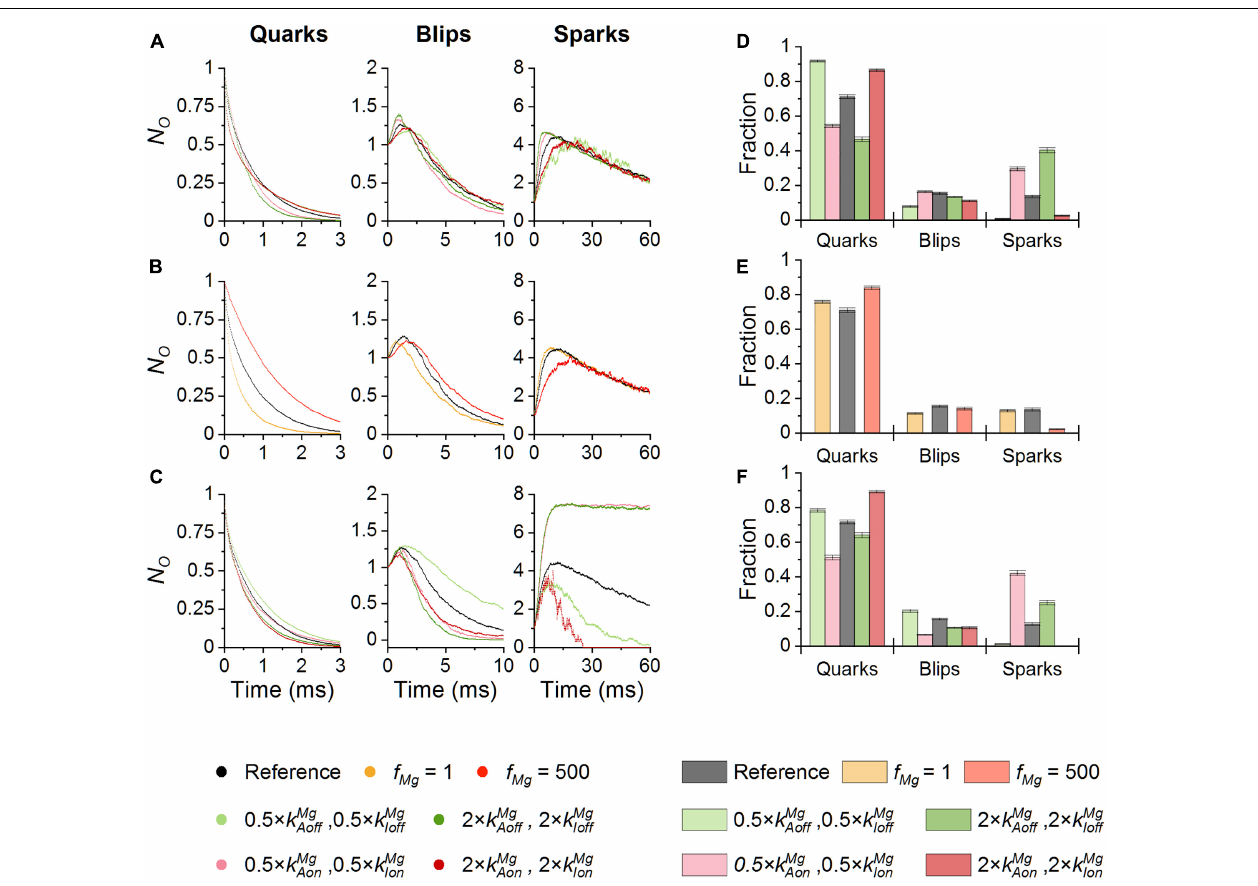
FIGURE 6 | The effect of Mg-binding parameters on CREs. Simulations were performed at 100 nM Ca 2 + and i Ca of 0.6 pA. (A,D) The effect of Mg-binding parameters at the activation site on the time course (A) and the fraction (D) of CREs. (B,E) The effects of the allosteric coefficient f Mg on the time course (B) and the fraction (E) of CREs. (C,F) The effect of Mg-binding parameters at the inhibition site on the time course (C) and the fraction (F) of CREs. Individual conditions are color-coded as indicated in the